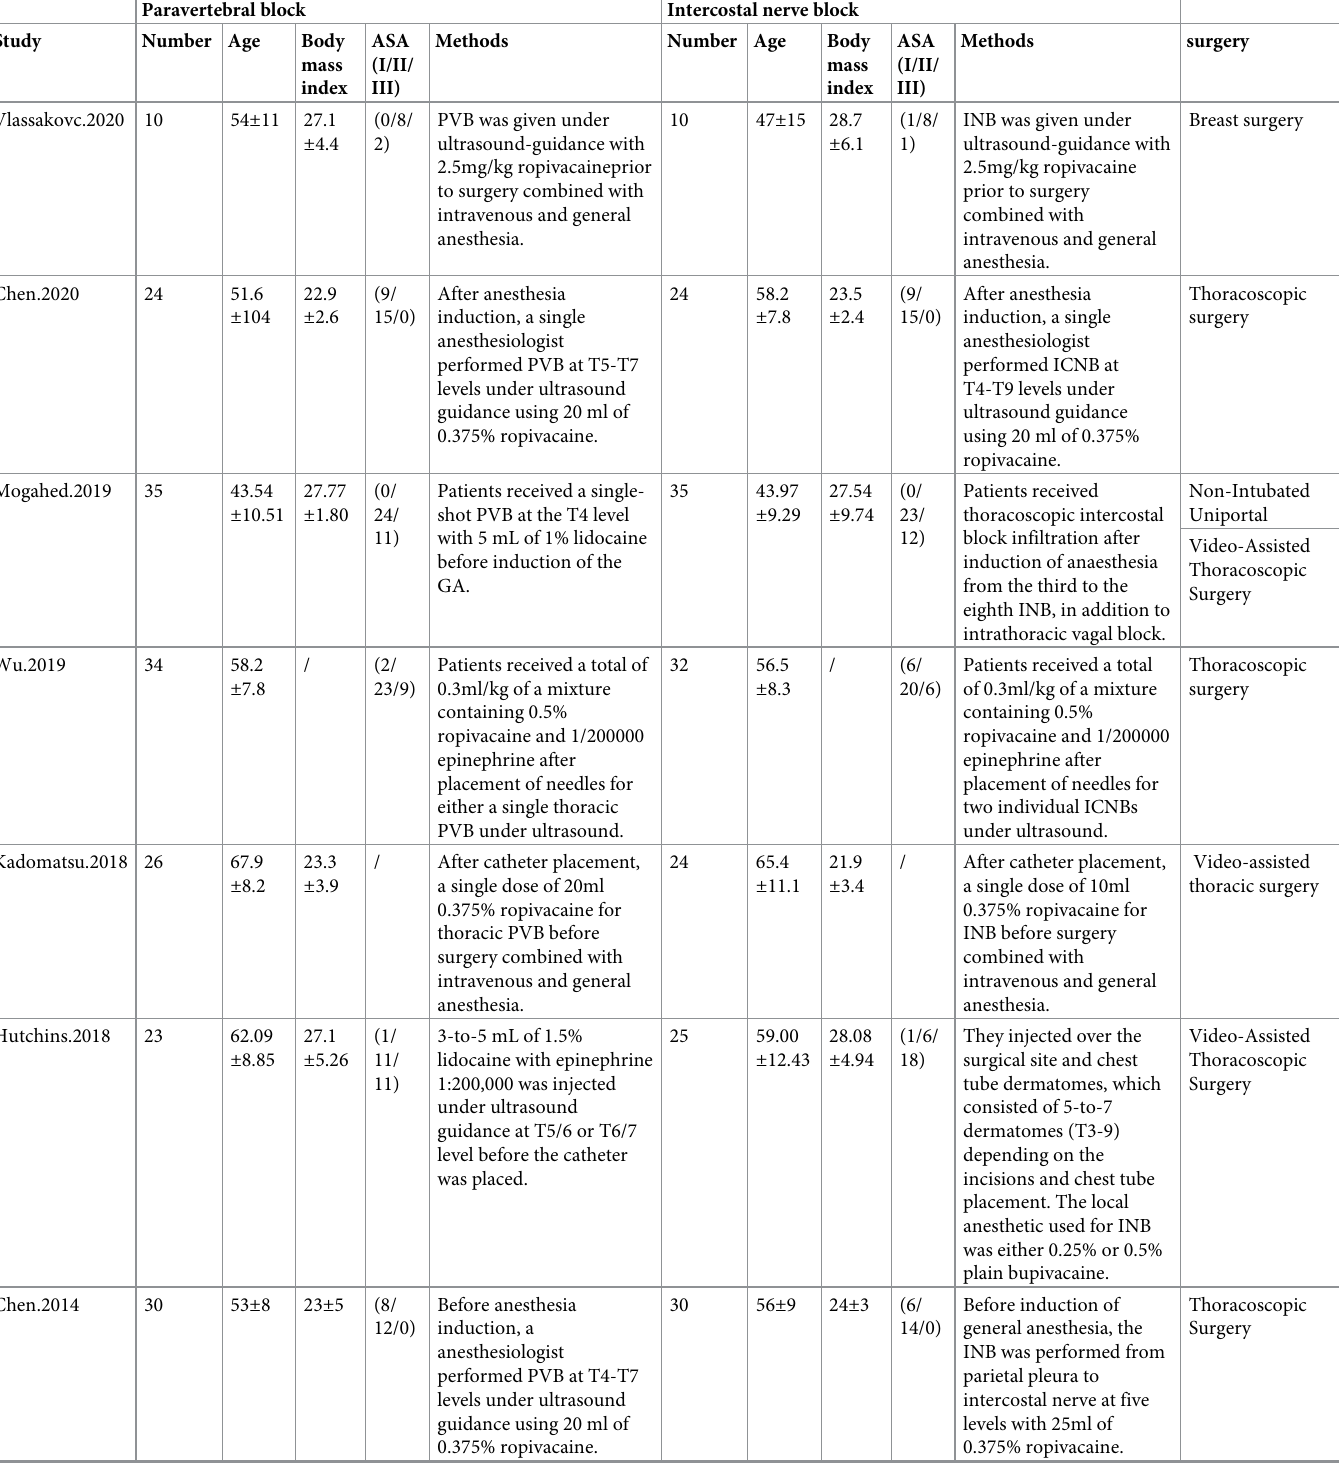
Table 1. Characteristics of included randomized controlled studies (Data presented as mean ± standard